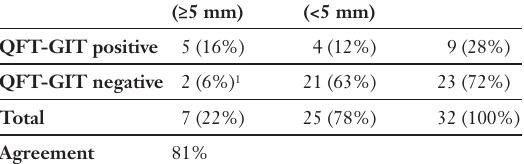
32 patients had a valid QFT-GIT and TST Median (range) Correlation with result and could therefore be used for a head to QFT-GIT PHA-control Correlation of possible reaction head comparison of the test performances. Of the factors influencing 9 patients with a positive QFT-GIT, two also had QFT-GIT test performance (INF- g a positive TST ≥10 mm (table 3A). Another three concentration of the patients with a positive QFT-GIT could have PHA-control reaction) been recognised by a TST cut-off of ≥5 mm (table in HD-patients (n = 37, Spearman R 3B). Nevertheless 8 and 5 patients, respectively, correlation). were detected by QFT-GIT only. All positive QFT-GIT results were found in patients with risk factors associated with probable LTBI. A positive IGRA result was closely associ- ated with previous TB-exposure and subsequent probable LTBI, as was the TST using a lower cut- off of ≥5 mm (for both p <0.05). In contrast, a TST ≥10 mm was not associated with previous TB ex- posure (p = 0.21) (fig. 3). The INF- g secretion upon TB-specific stimulation was not different in QFT-GIT positive HD-patients (n = 10) com- pared with QFT-GIT positive healthy controls (n = 11) (median INF- g secretion 2.5 (range 0.8–9.9) vs 1.1 (range 0.5–7.6) IU/ml) (fig. 1). QFT-GIT positivity was independent of the immunization status. Two patients with a TST ≥5 mm with known BCG-immunization and no Association between risk factors for LTBI remained QFT-GIT nega- TST (cut-off ≥10 mm) tive. Most patients (85.7%) with a history of prior and QFT-GIT results in BCG immunization were TST negative. HD-patients, excluding patients withoutTST or inconclusive QFT-GIT result (n = 32).